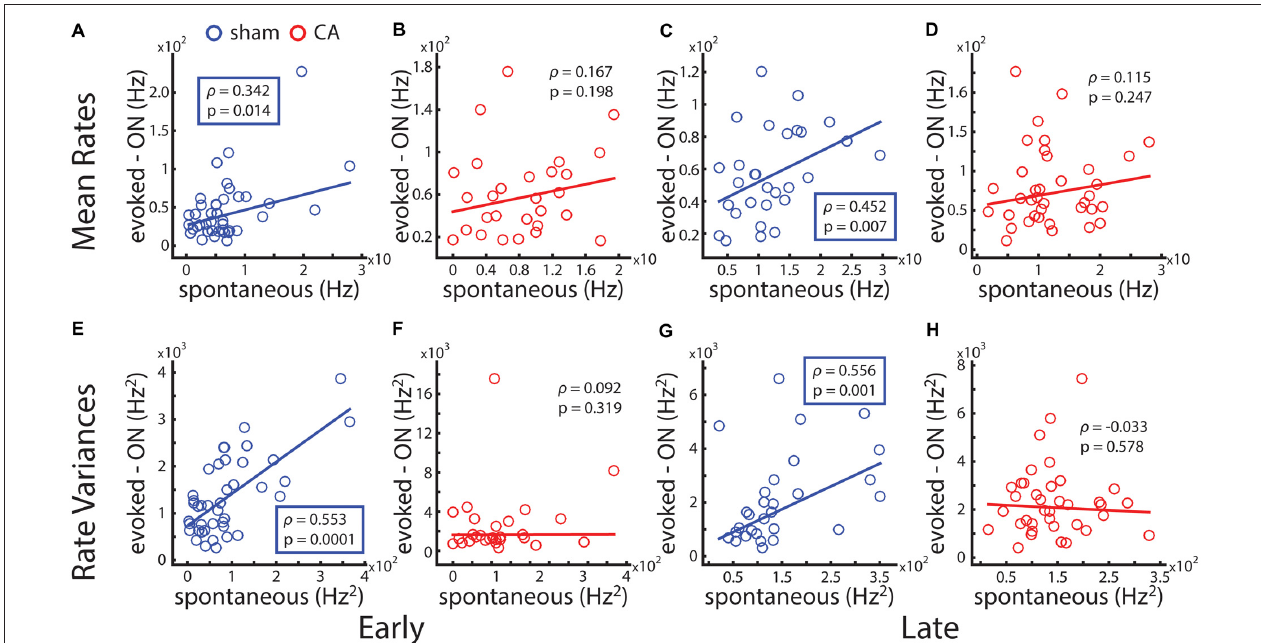
FIGURE 4 | Correlation of spontaneous and deflection-evoked activity is affected by ischemic injury. (A) The average level of spontaneous activity a thalamocortical neuron exhibits and its average whisker evoked stimulus response count is positively correlated across the population of neural recordings in early sham rats. (B) Spontaneous-evoked rate correlation is not significant for early CA rats. (C) Spontaneous-evoked rate correlation is positive and significant for late sham rats. (D) Spontaneous-evoked rate correlation is not significant for late CA rats. (E) Spontaneous-evoked variance correlation is positive and significant for early sham rats. (F) Spontaneous-evoked variance correlation is not significant for early CA rats. (G) Spontaneous-evoked variance correlation is positive and significant for late sham rats. (H) Spontaneous-evoked variance correlation is not significant for late CA rats.